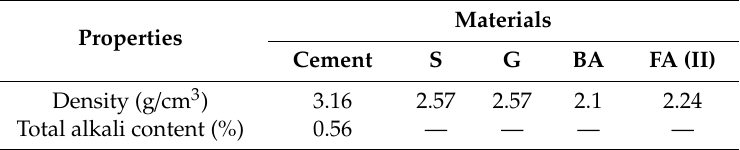
Table 1. Physical properties of cement and aggregates.